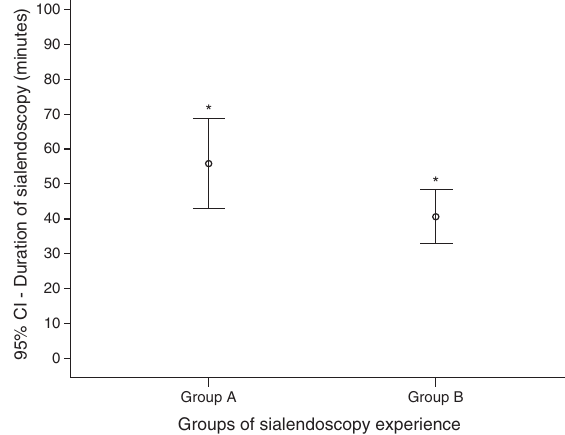
Figure 5 Comparison between means of sialendoscopy dura- tion (min) according to early and late groups of surgeon experience (*Student t -test, p =